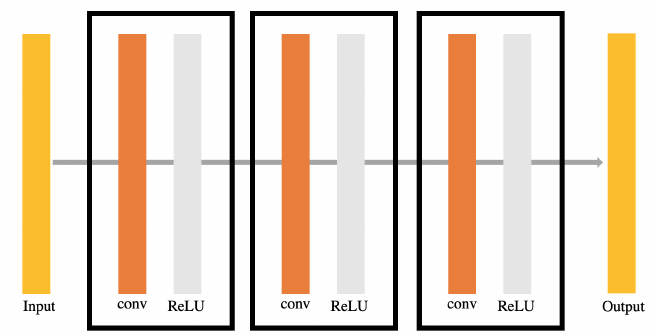
Figure 3. The Structure of SRCNN: Whereas Figure 2 mentioned what function each layer performs in an SRCNN structure, more specifically, this structure uses ReLU as its activation function [16].